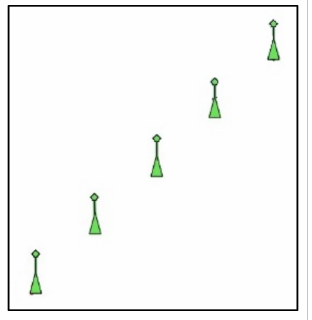
Figure 13. Template with five false AIS